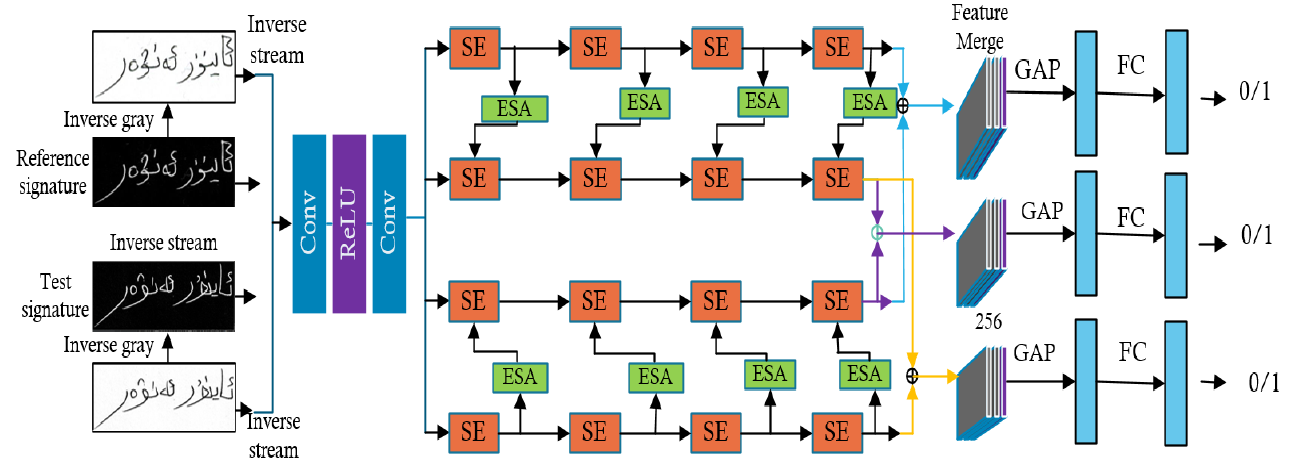
Figure 4. Proposed signature verification system.